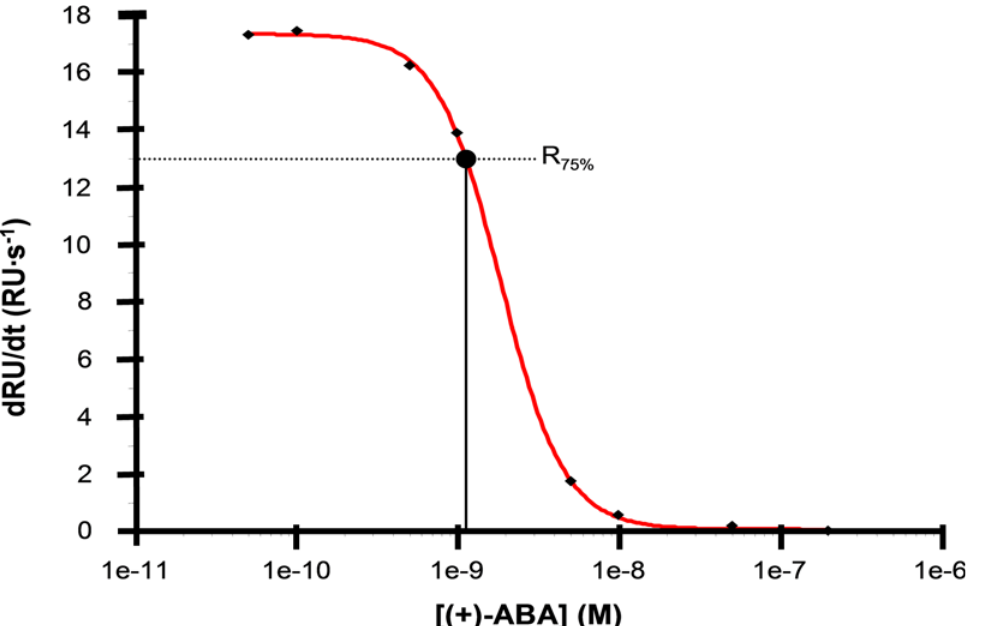
Fig 3. Affinity in solution 15-I-C5. Monoclonal 15-I-C5 (5 nM) was mixed with different concentrations of (+)-ABA (0.5 – 500 nM) for 1 hour at 25°C. The equilibrium mixtures were injected over a sensor chip surface with high b-PEG-ABA density and the initial binding slopes were measured for each sample. The values were plotted against the concentration of free ABA and the data points were fitted to a 4-parameter equation. KD was estimated from the corrected inflection midpoint of the fitted curve (Stöcklein et al., 1998). The affinity in solution of 15-I-C5 for (+)-ABA was estimated to 1.13 nM.